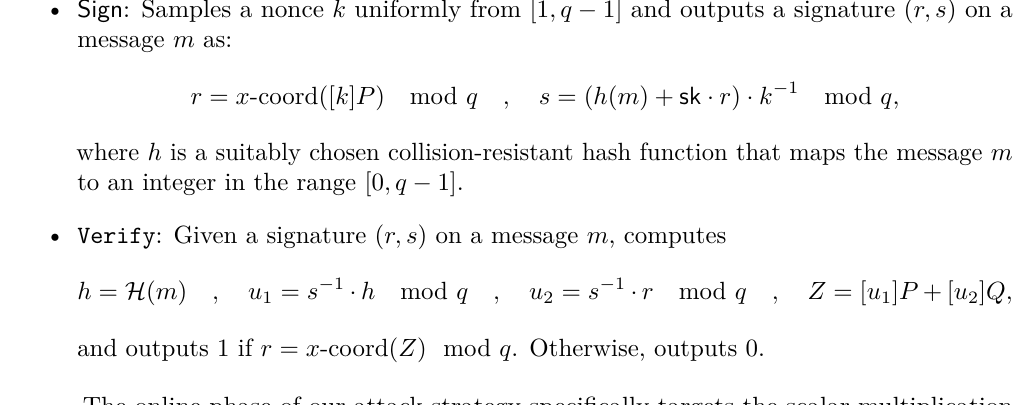
Figure 11: Number of add-sub calls and timing values observed for keys key1 and key2 for bit index 0 to